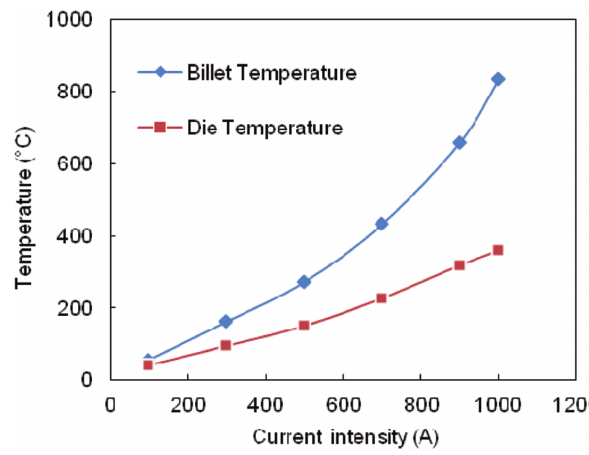
Figure 4: Effect of current intensity on temperature